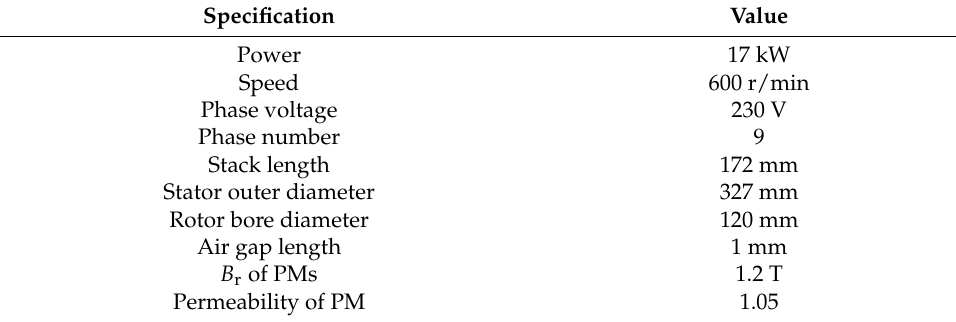
Table 1. Key design parameters of the nine-phase FSPM